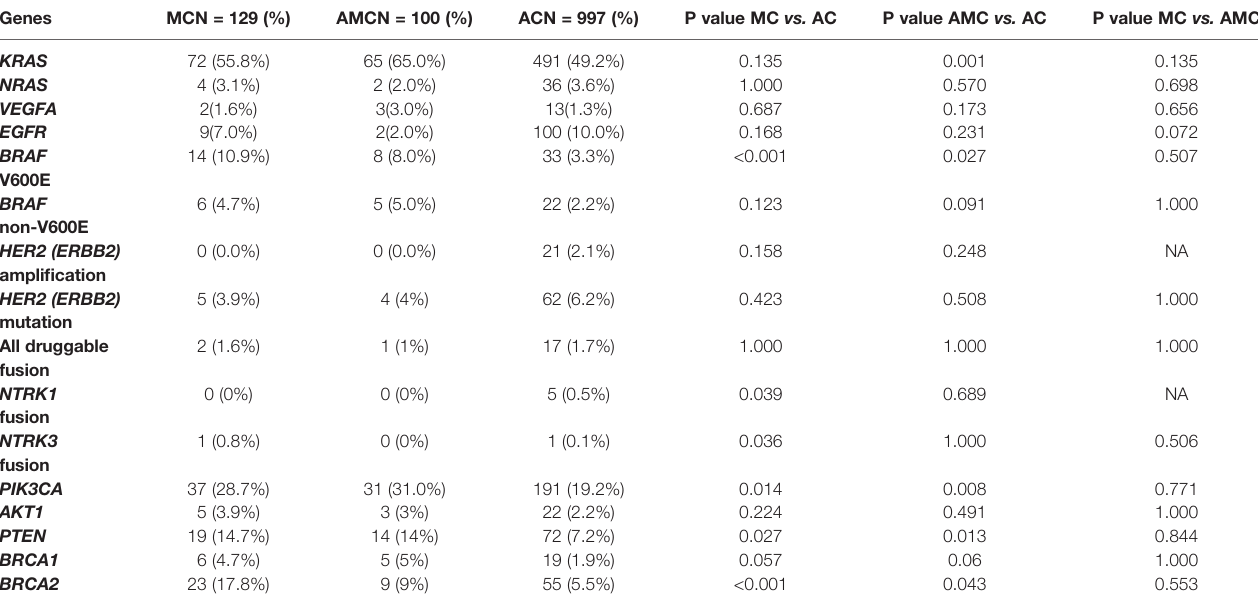
TABLE 2 | Comparison of clinically actionable gene alterations in MC, AMC, and AC.